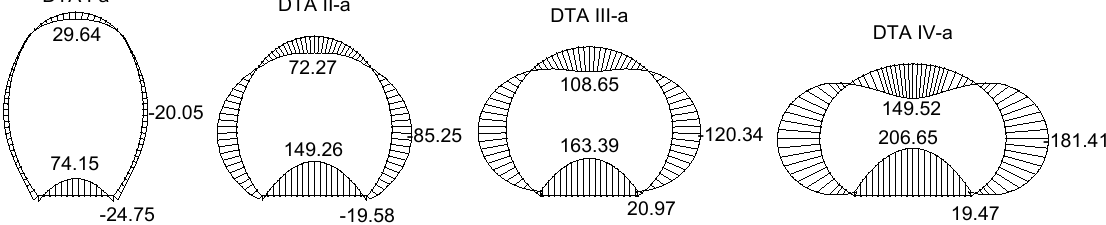
Figure 10. Diagrams of bending moments (kN·m) for culverts defined by three arcs.